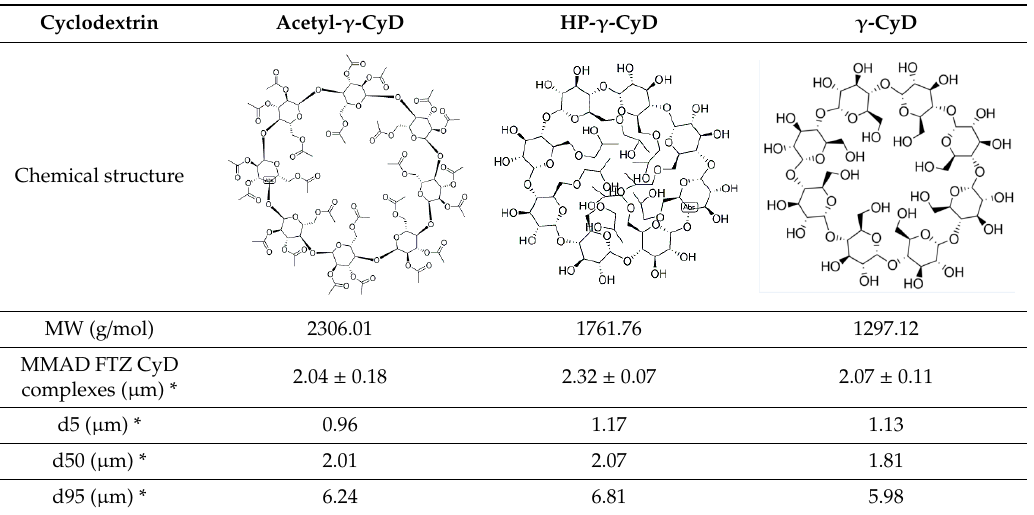
Table 3. Physical properties of cyclodextrin (CyDs) used and mass median aerodynamic diameter (MMAD) of the FTZ CyD complexes *.